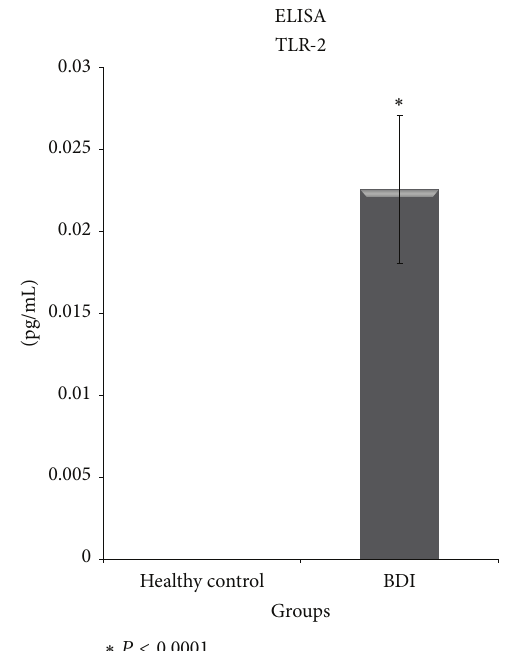
Figure 2: ELISA of TLR-2 IN postcholecystectomy BDI. In the control group it was not possible to detect levels of TLR-2; however, in BDI levels of TLR-2 were significantly detected, suggesting an innate and adaptive response to bacterial colonization.